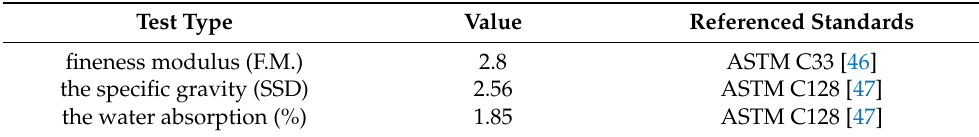
Table 3. Physical properties of natural fine